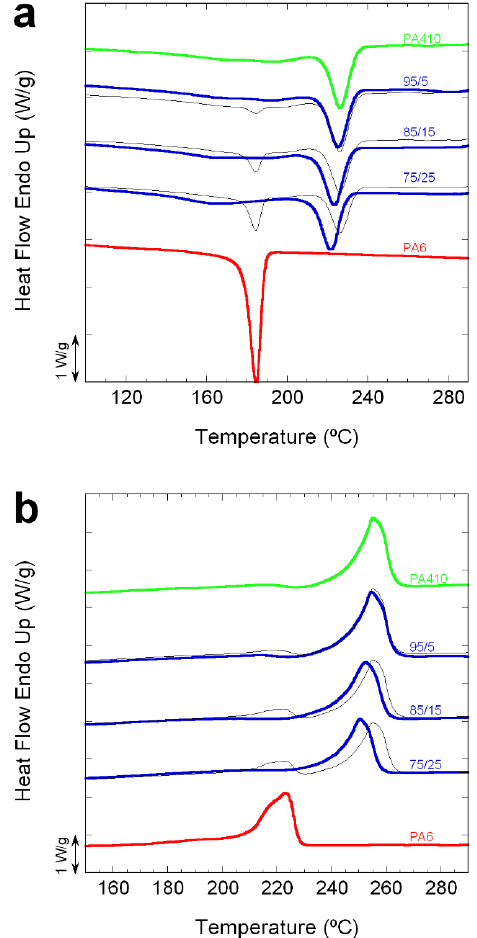
Figure 3. Normalized experimental (thick lines) crystallization ( a ) and melting ( b ) DSC curves of PA410, PA6, and 95/5, 85/15 and 75/25 PA410/PA6 blends. Thin black lines correspond to the calculated curves (assuming full immiscibility between both PAs). Curves have been shifted in the vertical axis. Table 2. Calorimetric parameters of PA410/PA6 blends.